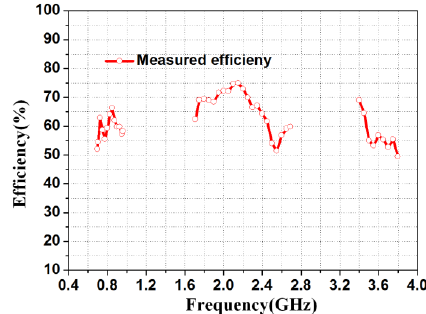
Figure 9. Measured efficiencies of the proposed antenna.